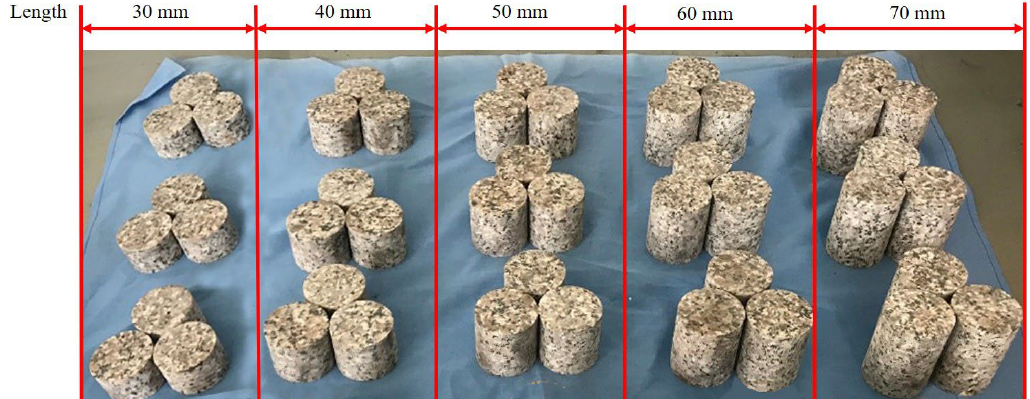
Figure 1. Granite specimens with five length–diameter ratios.